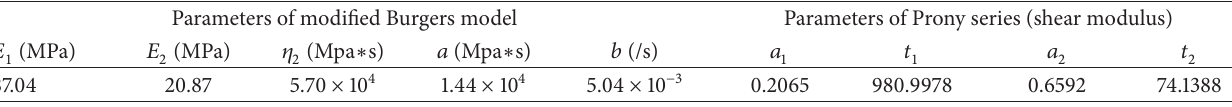
Table 1: Material properties of the calculation example.